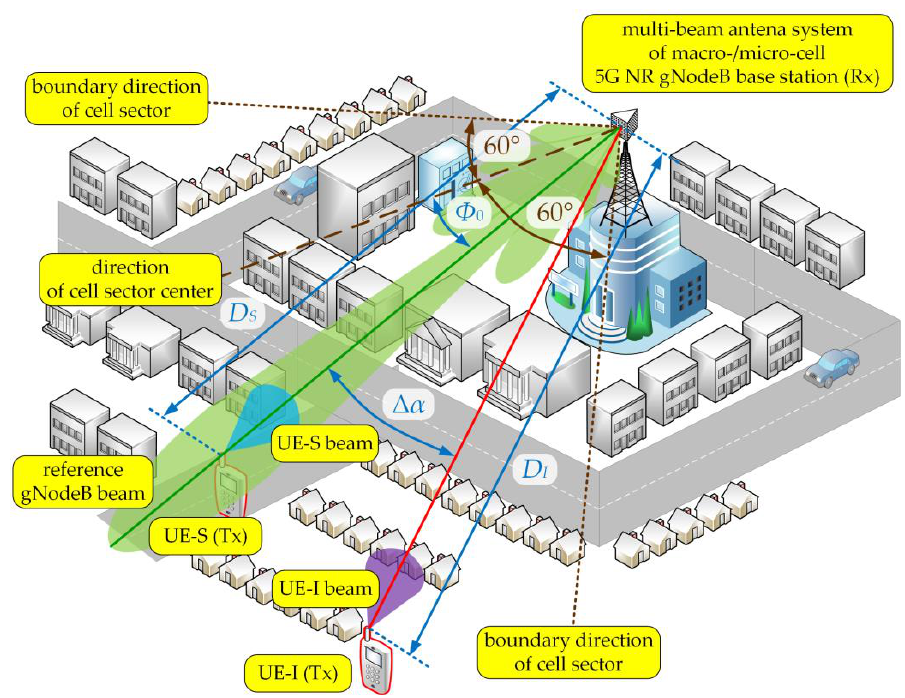
Figure 3. UL spatial scenario of simulation studies.